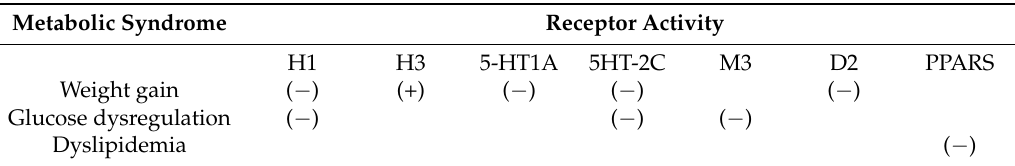
Table 3. Receptors related to metabolic